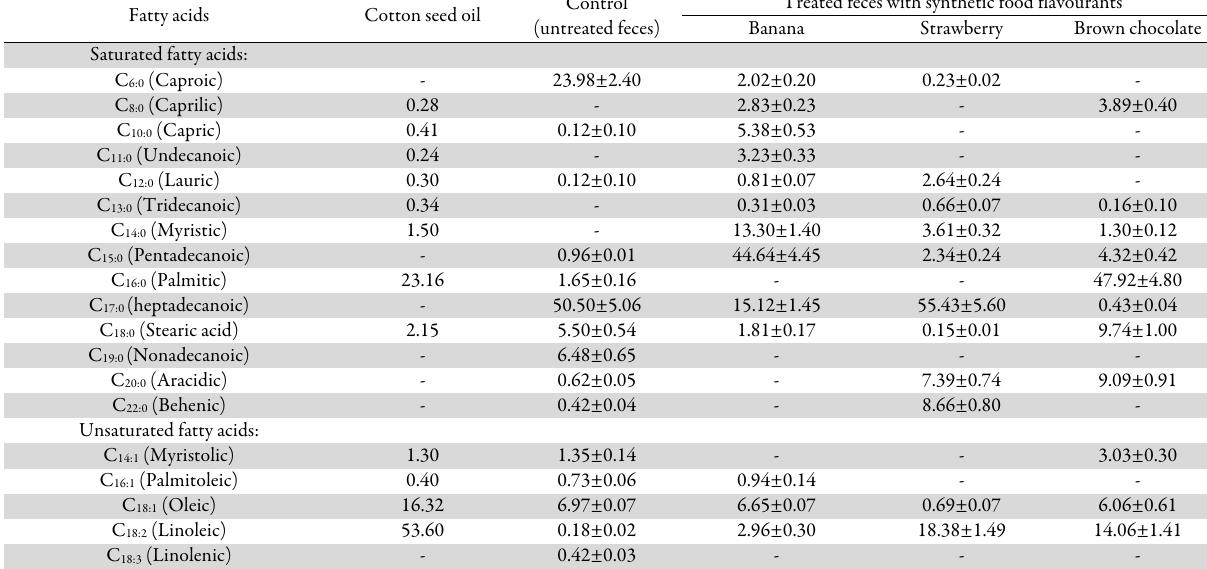
Table 5. Relative percentage of fatty acids in rat feces affected by synthetic food flavourants Fatty acids Cotton seed oil